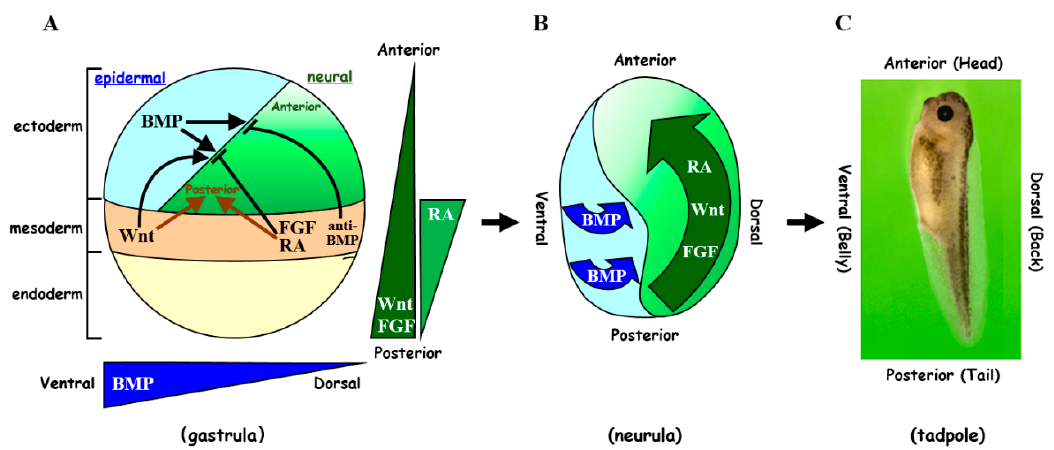
Figure 1. Cell fate specification by morphogen signaling during body axis formation in Xenopus embryos. ( A ) At the gastrula stage, bone morphogenetic protein (BMP) and Wnt ligands promote the epidermal fate of the ectoderm on the ventral side. Neural tissue is formed from the ectoderm when BMPs are inhibited by BMP antagonists (anti-BMP; Noggin, Chordin, and Follistatin) emanating from the dorsal mesoderm (Spemann’s organizer), which later becomes the notochord. ( B ) By the neurula stage, the induced neural tissue is regionalized along the anterior-posterior (AP) axis by the posteriorizing factors fibroblast growth factor (FGF), Wnt, and retinoic acid (RA), and the neural plate above the notochord forms the neural tube which will develop into the brain and spinal cord. ( C ) By the tadpole stage, a variety of organs and tissues such as brain, eyes, somites, and tail are formed along the dorsal–ventral (DV) (back–belly) and AP (head–tail) axes. Green, neural/dorsal ectoderm; blue, epidermal/ventral ectoderm; orange, mesoderm (marginal zone); yellow, endoderm.